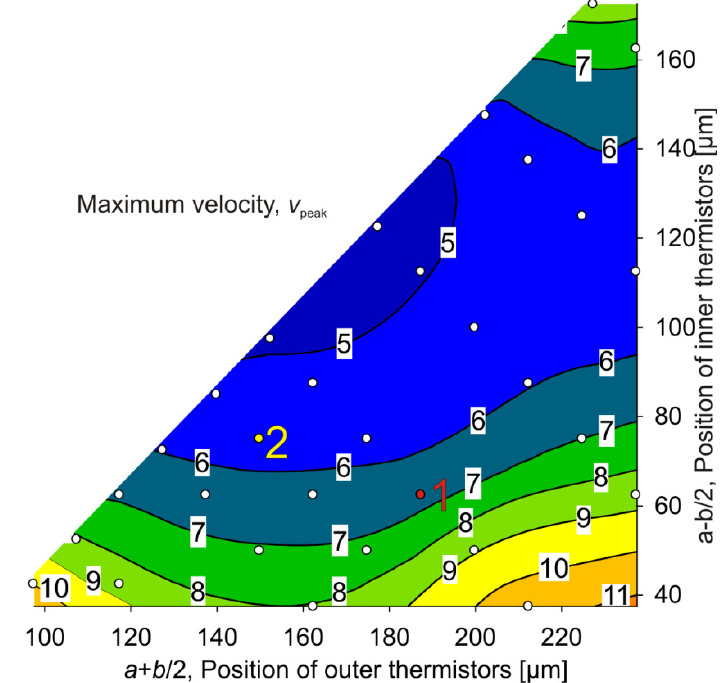
Figure 11. Contour plot of the simulated velocity v [m/s], which marks the boundary of peak the monotonous transduction characteristic. The available region for possible designs is plotted using the position of inner and outer thermistors as design parameters. The designs of implemented devices are indicated by respective numbers (designs 1 and